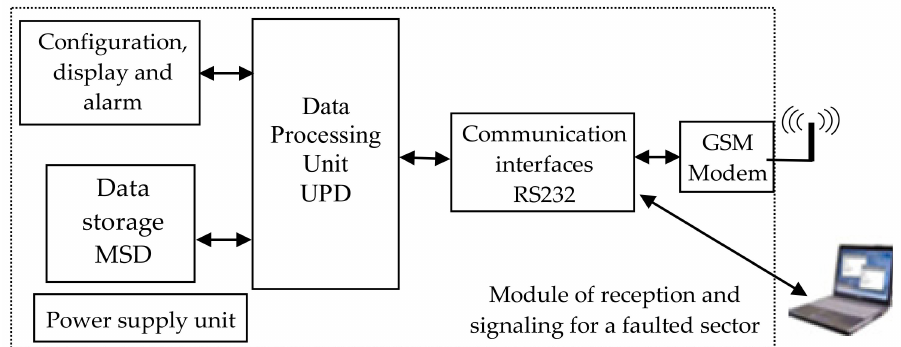
Figure 6. Schematic diagram of the module of reception and signaling of the faulty block